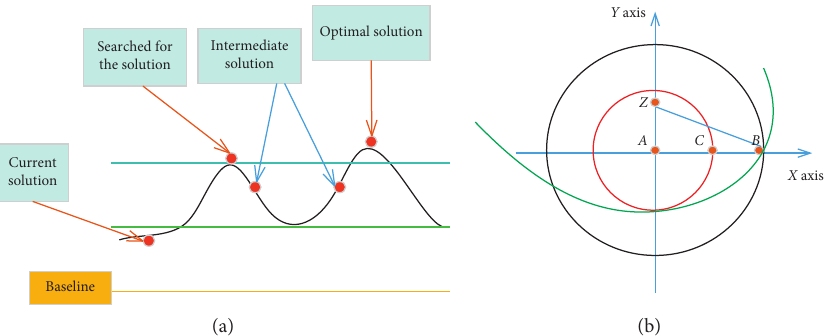
Figure 3: Principle diagram of hill climbing algorithm and golden section. (a) Schematic diagram of mountain climbing algorithm. (b) Schematic diagram of golden